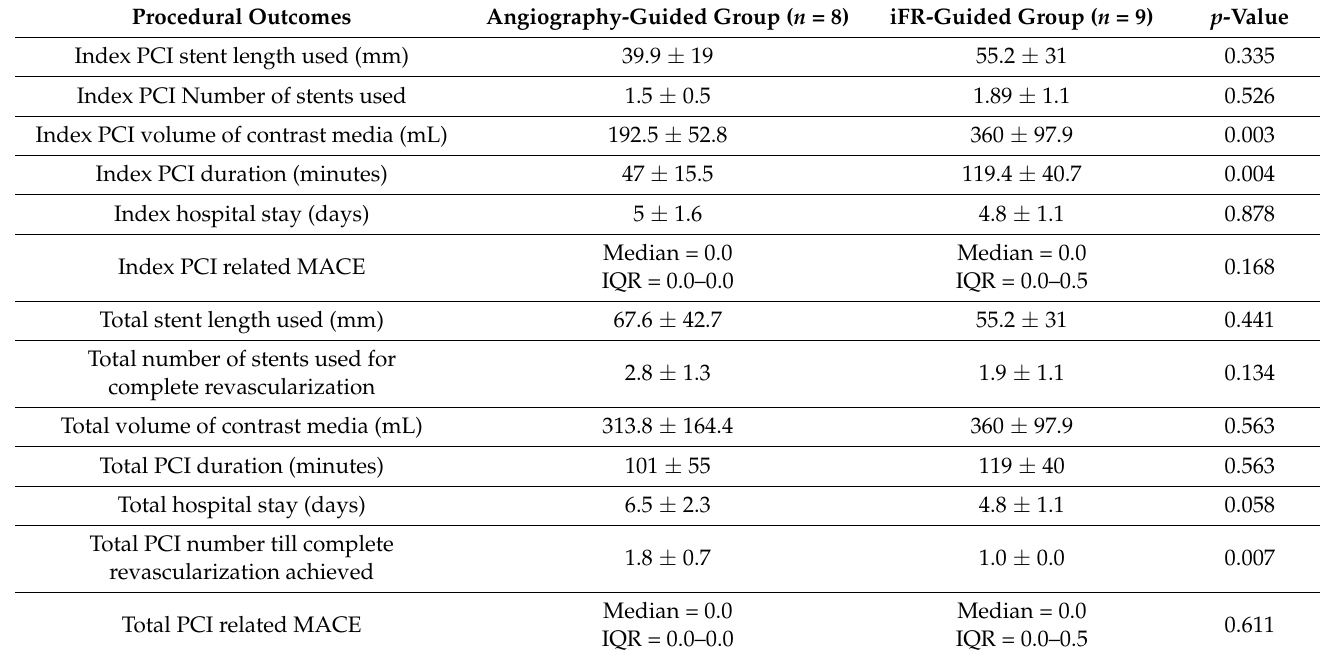
Table 2. Index procedure and complete coronary revascularization outcomes of patients undergoing complete revascularization in one-stage iFR-guided PCI versus staged angiography-guided PCI at the 3-month